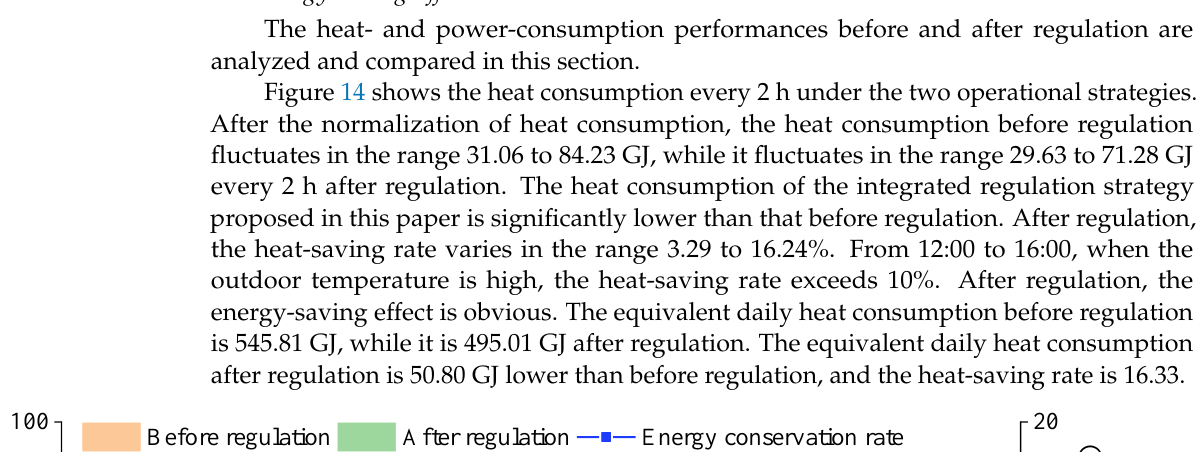
Figure 13. Comparison of user indoor-temperature distribution frequency between two operating strategies.